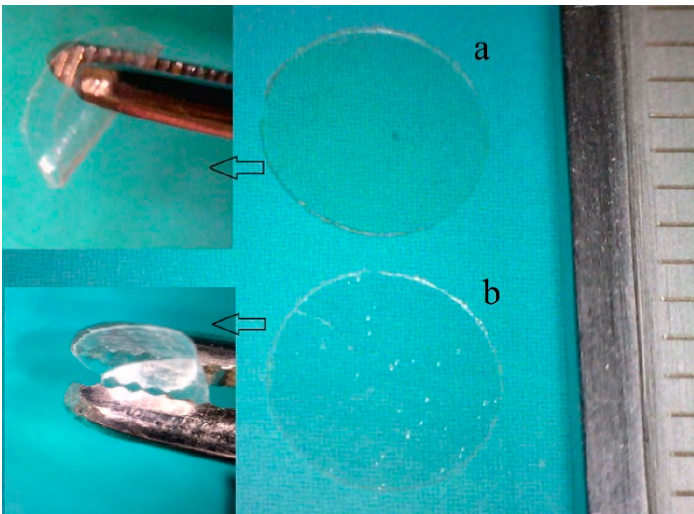
Figure 5. Ocular inserts with Eudragit ® L100 nanoparticles for azithromycin drug delivery. ( a ) AZM film-HPMC and ( b ) AZM film-HEC. Note: Scale: 1 mm.